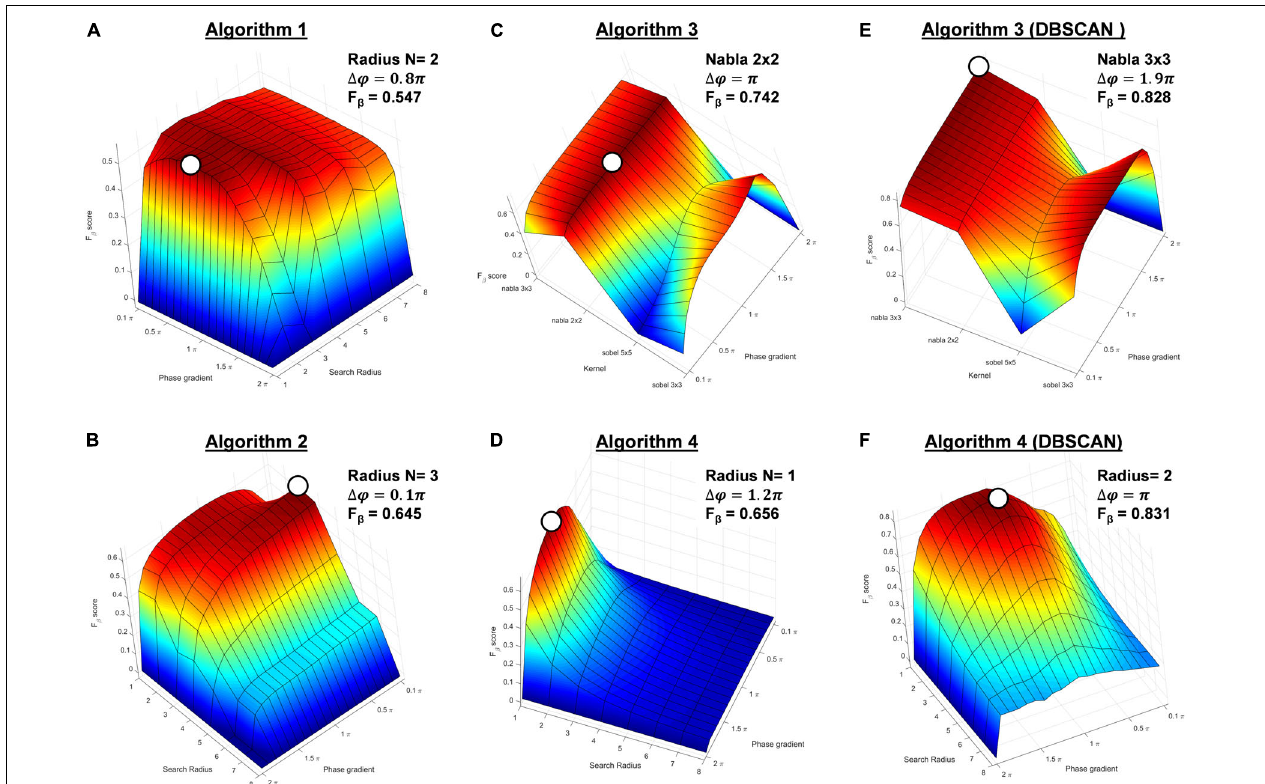
FIGURE 8 | The surface and line plots of F β score of the testing data sets of all possible combinations of phase gradient and search radius (kernels for Algorithm 3 and Algorithm 3 + DBSCAN) thresholds of (A) Algorithm 1, (B) Algorithm 2, (C) Algorithm 3, and (D) Algorithm 3 + DBSCAN, (E) Algorithm 4, and (F) Algorithm 4 + DBSCAN (optimal settings regarding each metric highlighted as with